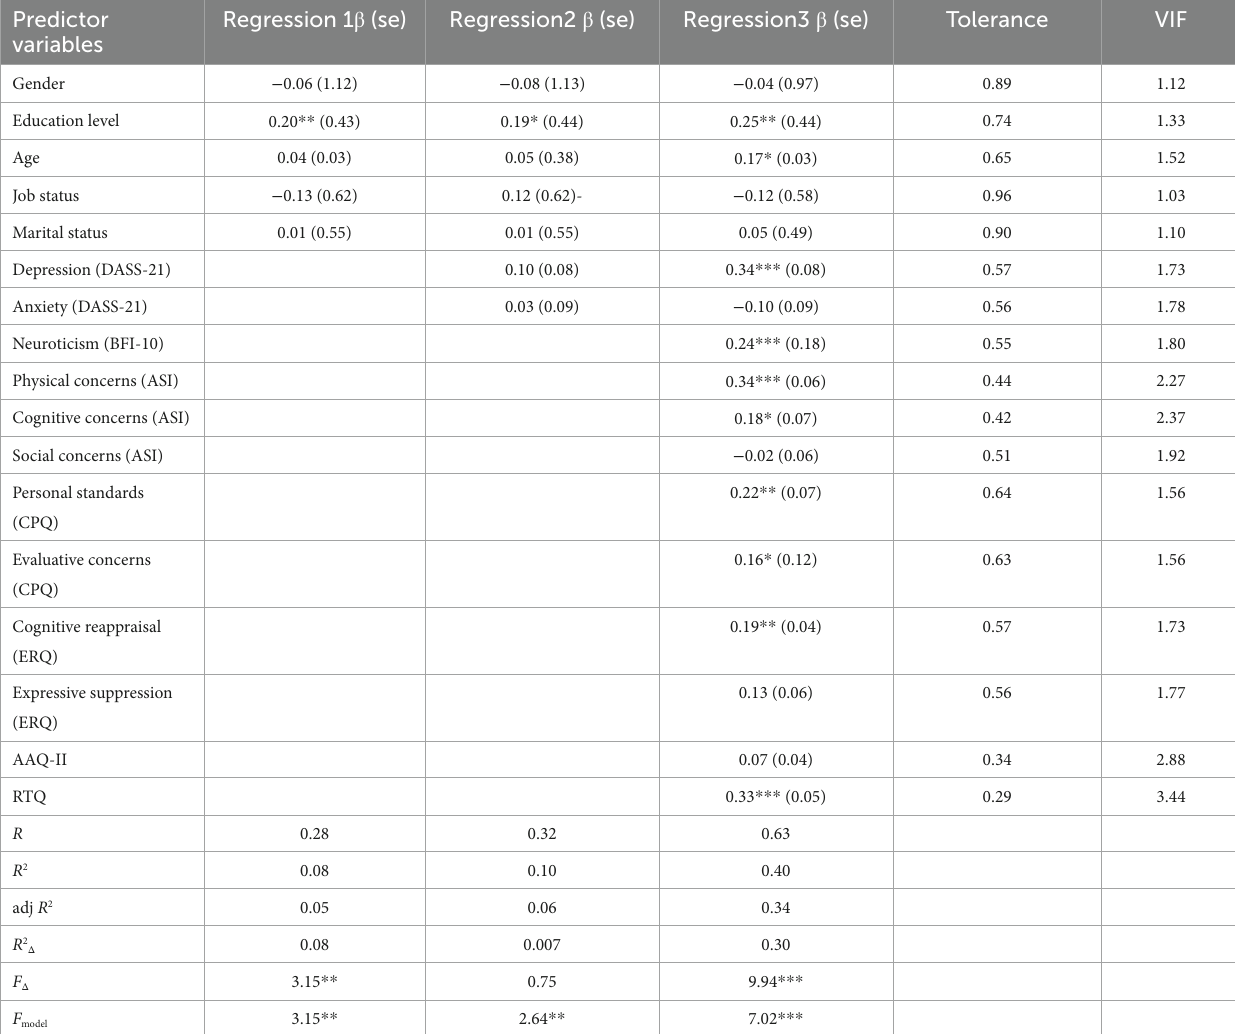
TABLE 2 Hierarchical multiple linear regression analyses for insomnia severity in insomniac